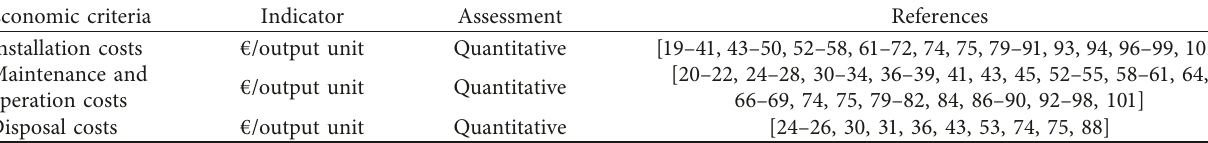
Table 1: Main economic criteria and indicators.